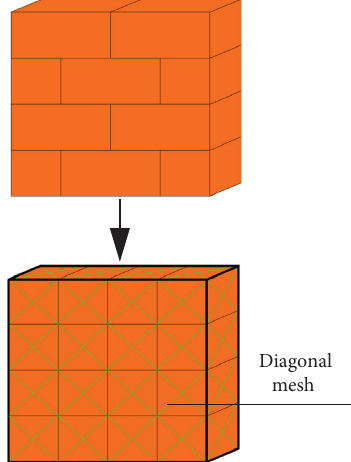
Figure 9: Diagonal finite element mesh.